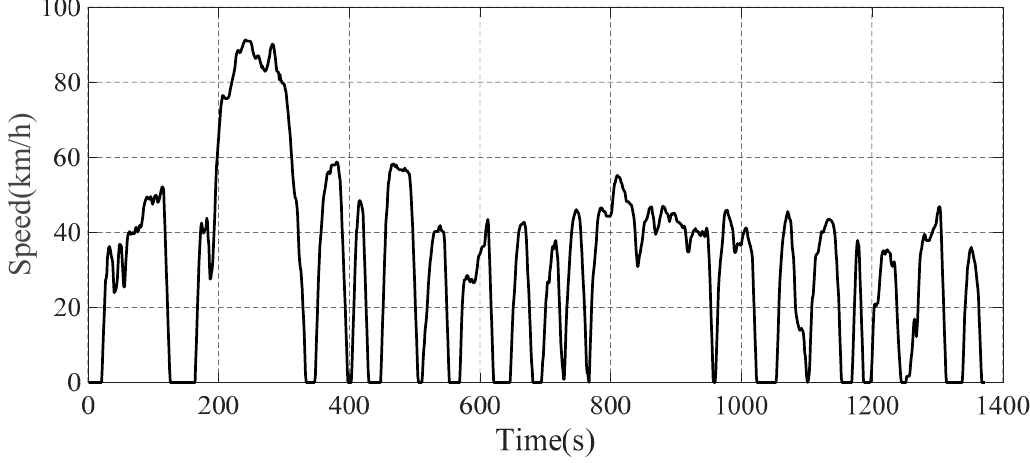
Figure 9. Simulated speed time course of the vehicle.